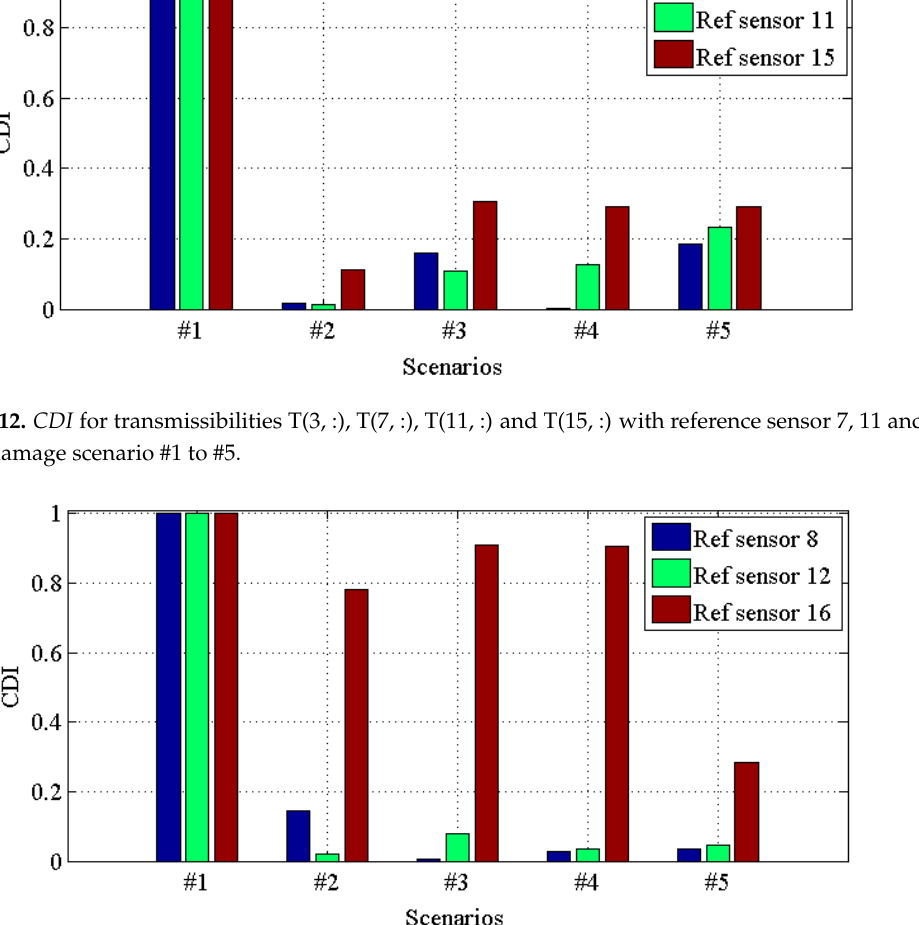
Figure 13. CDI for transmissibilities T(4, :), T(8, :), T(12, :) and T(16, :) with reference sensor 8, 12 and